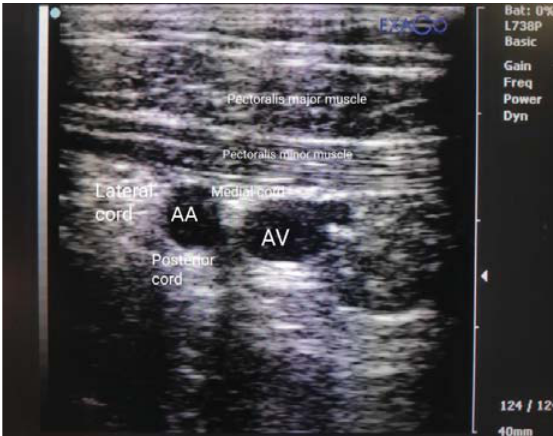
Figure 1. Ultrasound image of the infraclavicular region where ICB is given (AA=axillary artery,